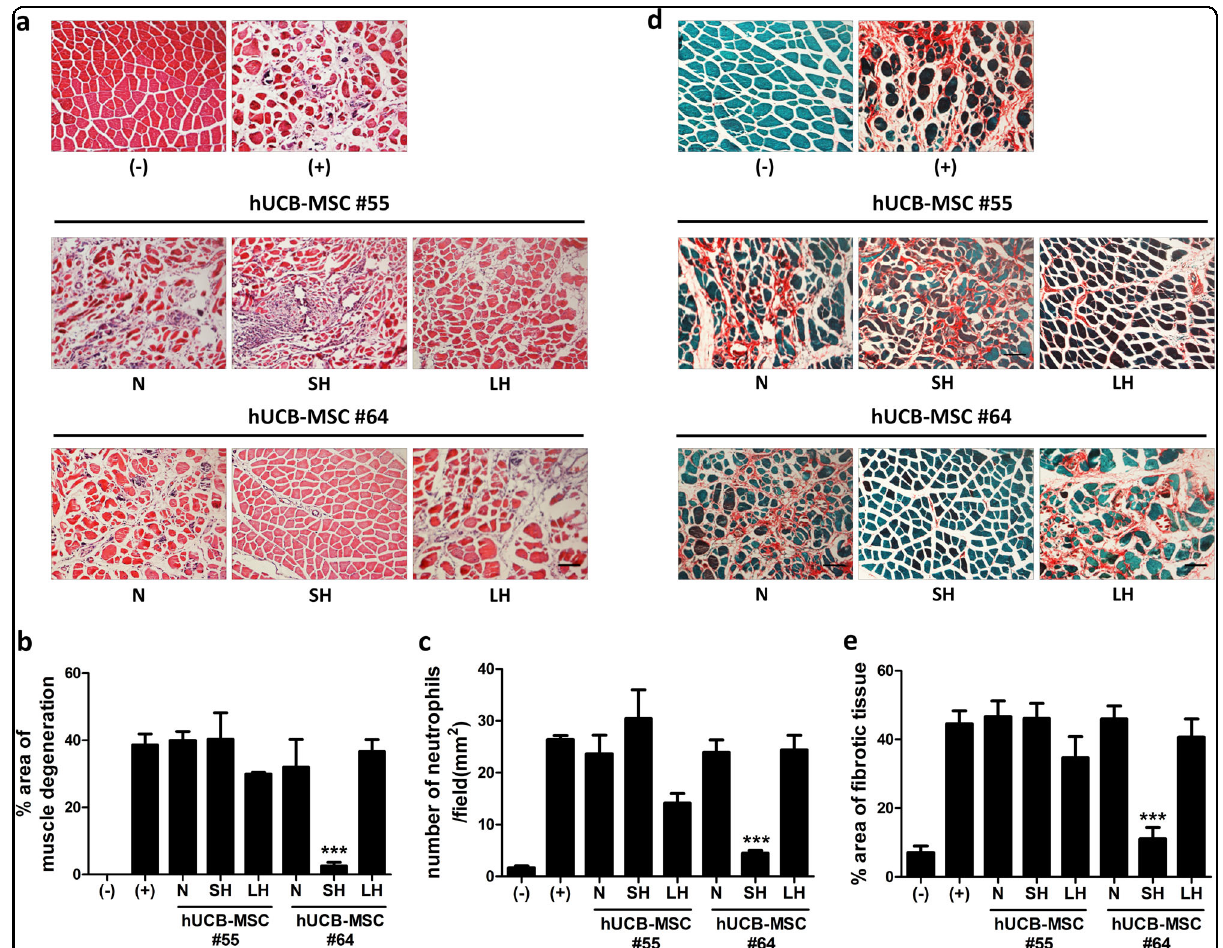
Fig. 3 Histopathological assessment of ischemic lesions after normoxic and hypoxic-preconditioned hUCB-MSCs administration. On Day 28, mice were killed for histopathological evaluation. a Paraf fi n-embedded sections of muscle samples from HLI mice were stained with hematoxylin and eosin, and b muscle degeneration and c the number of in fi ltrated neutrophils were measured, bar = 200 μ m. d The sections were stained with picrosirius red, and e muscle necrosis were measured, Scale bar = 200 μ m. Four to fi ve mice/group were used. *** P <0.001. Results are shown as the